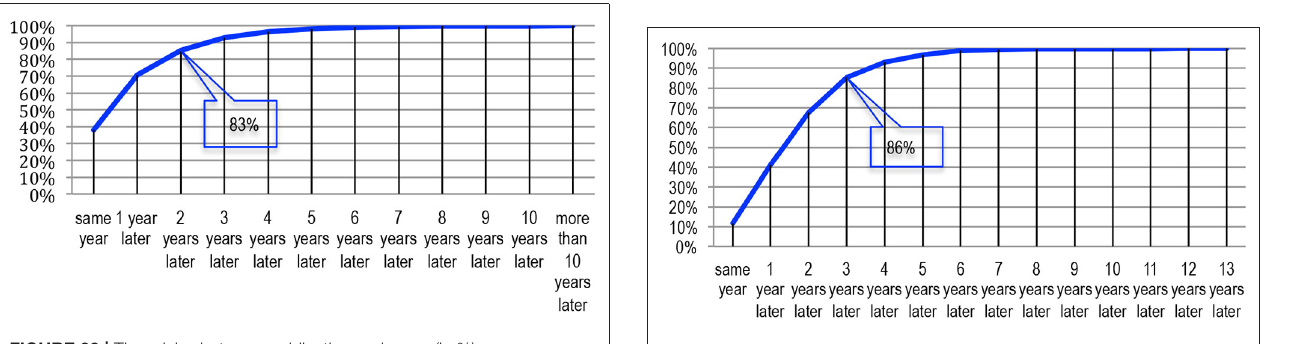
FIGURE 34 | Time delay between publication in conferences and reuse in journals (in